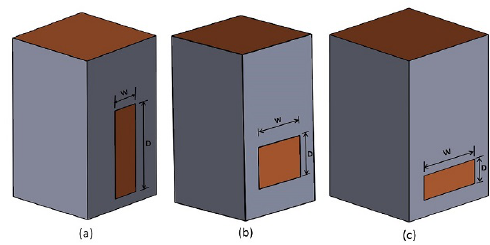
Figure 1. Sketches of bins with rectangular orifices in the vertical sidewalls: (a) vertically elongated slot ( W / D (cid:28) 1), (b) near squared slot ( W / D ≈ 1) and (c) horizontally elongated slot ( W / D (cid:29) 1).